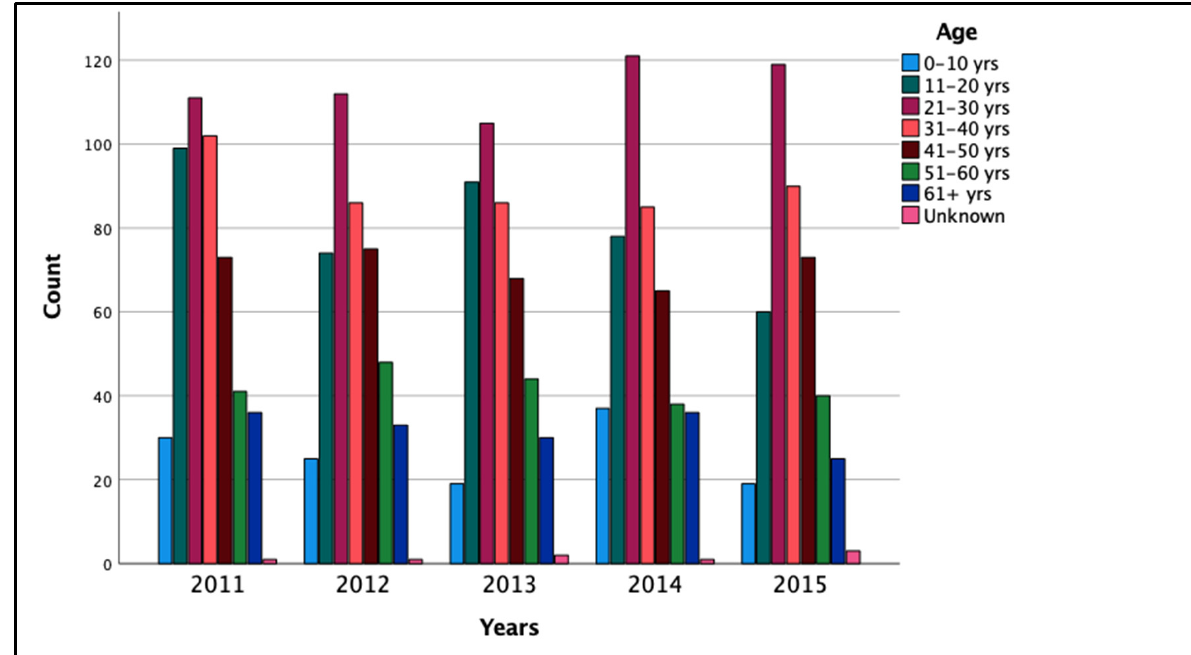
Figure 3. Total road traffic deaths in Kuwait by age from 2011 to 2015.